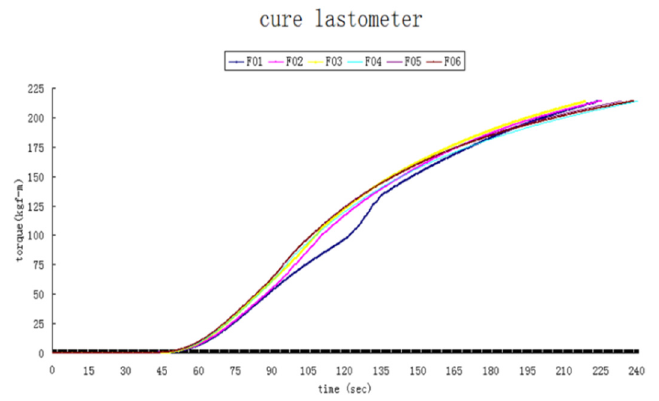
Figure 10. Effect of particle size on curing.